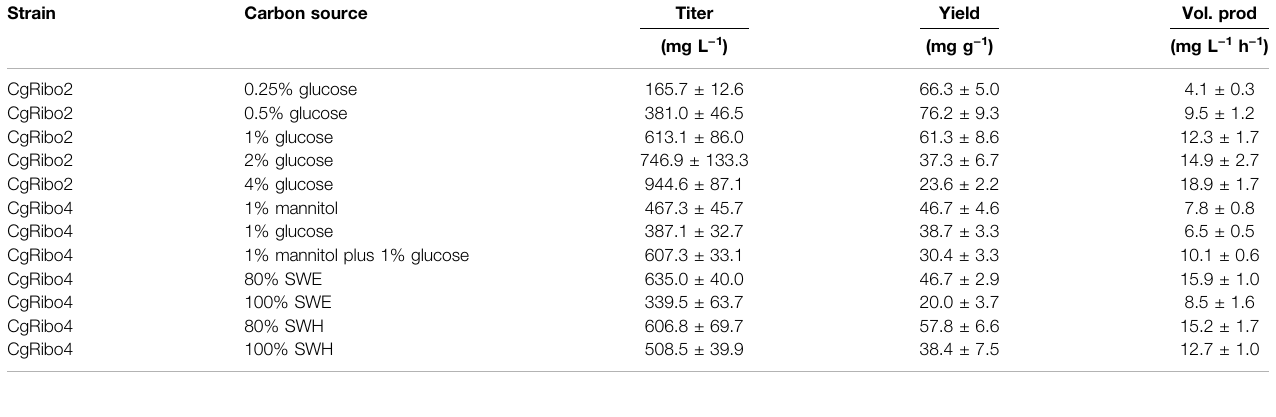
TABLE 6 | Ribo fl avin production values from fl ask fermentations. Strain